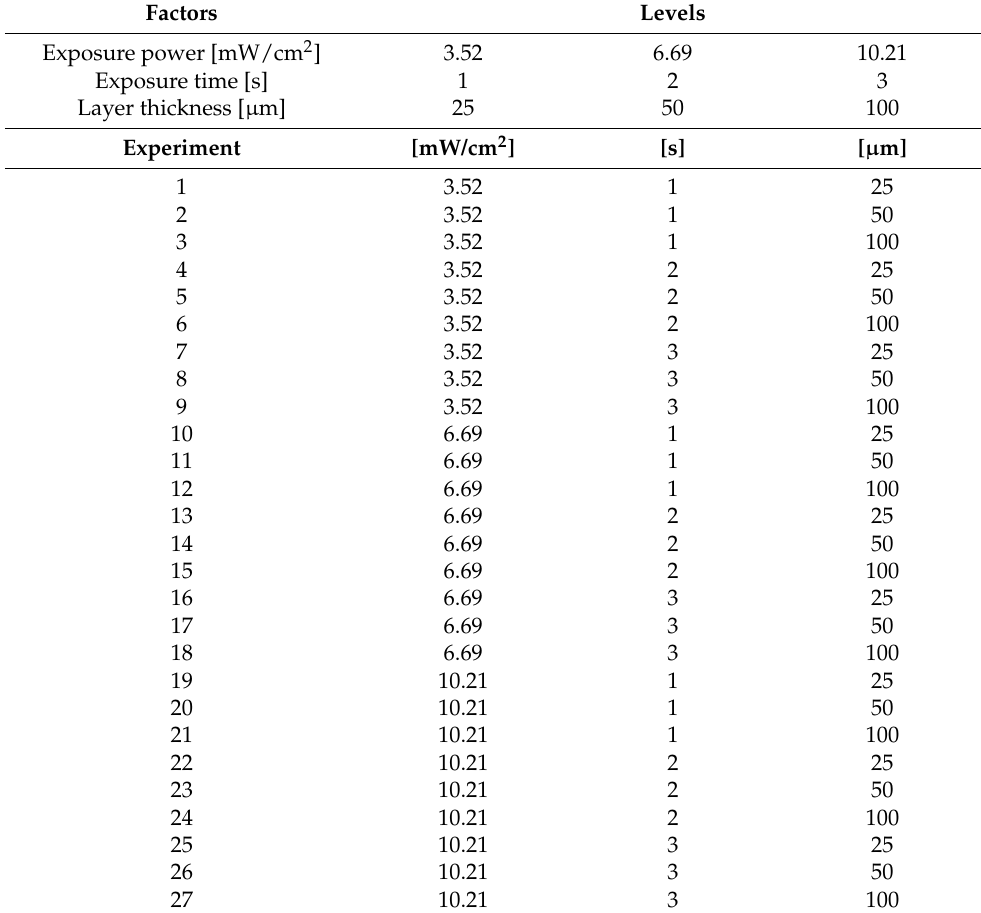
Table 4. DoE factors, levels, and experimental matrix of the DLP experimental campaign.